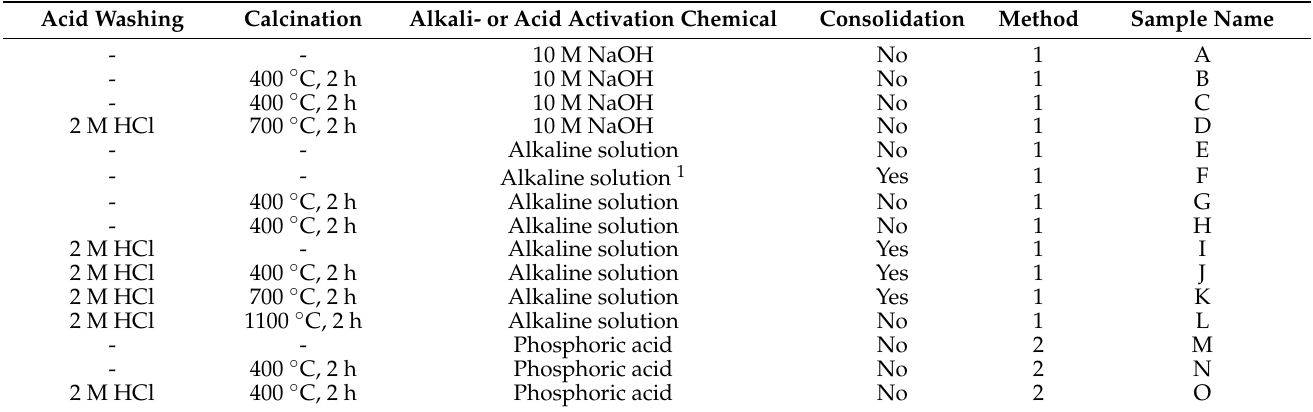
Table 1. Preparation conditions for the alkali- and acid activation of analcime. In one preparation method (F), metakaolin was used as a blending